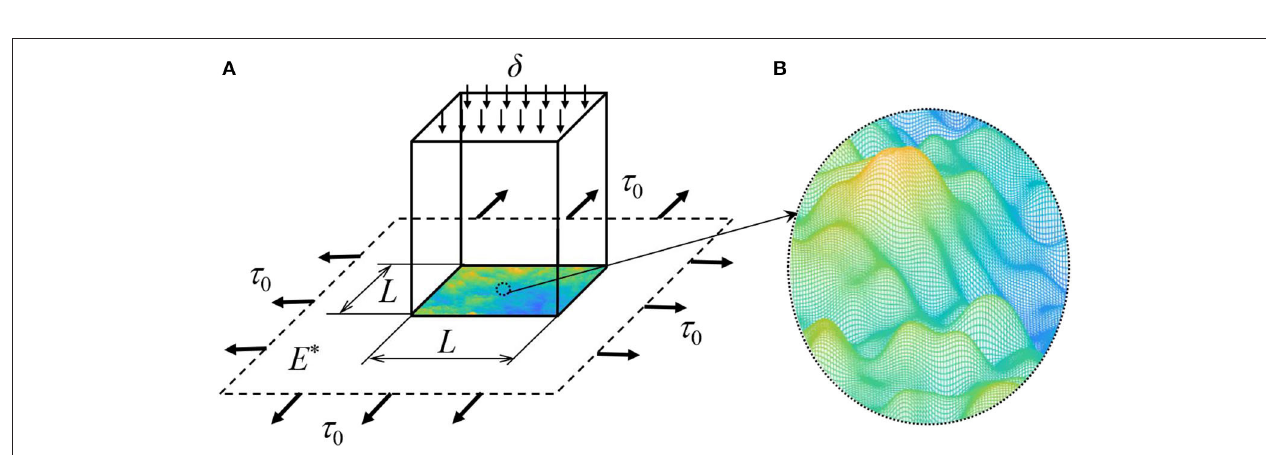
FIGURE 7 | (A) Indentation on the elastic half space by a square punch with fractal rough surface, and (B) the detail of generated rough surface.